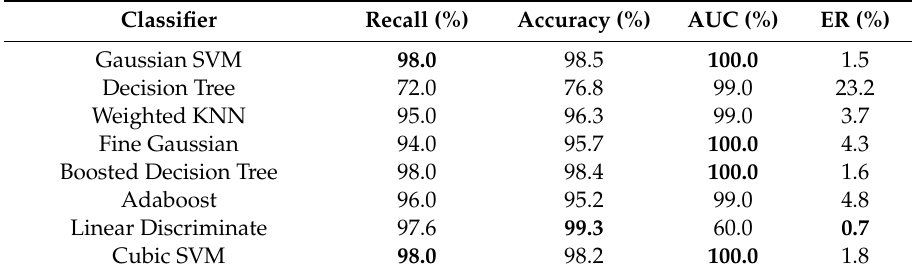
Table 4. Classification results using balanced data and SFTA features. Best values are shown in bold.